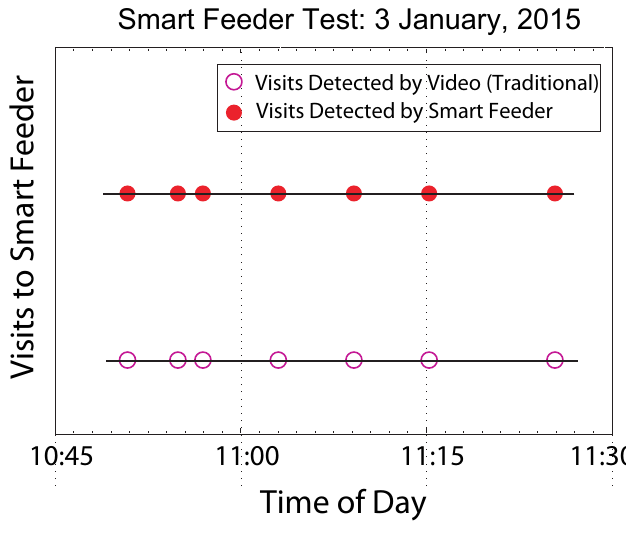
Figure 9. Comparison of detected LBH visits to a smart feeder based on video recording and RFID detection for a single trial.